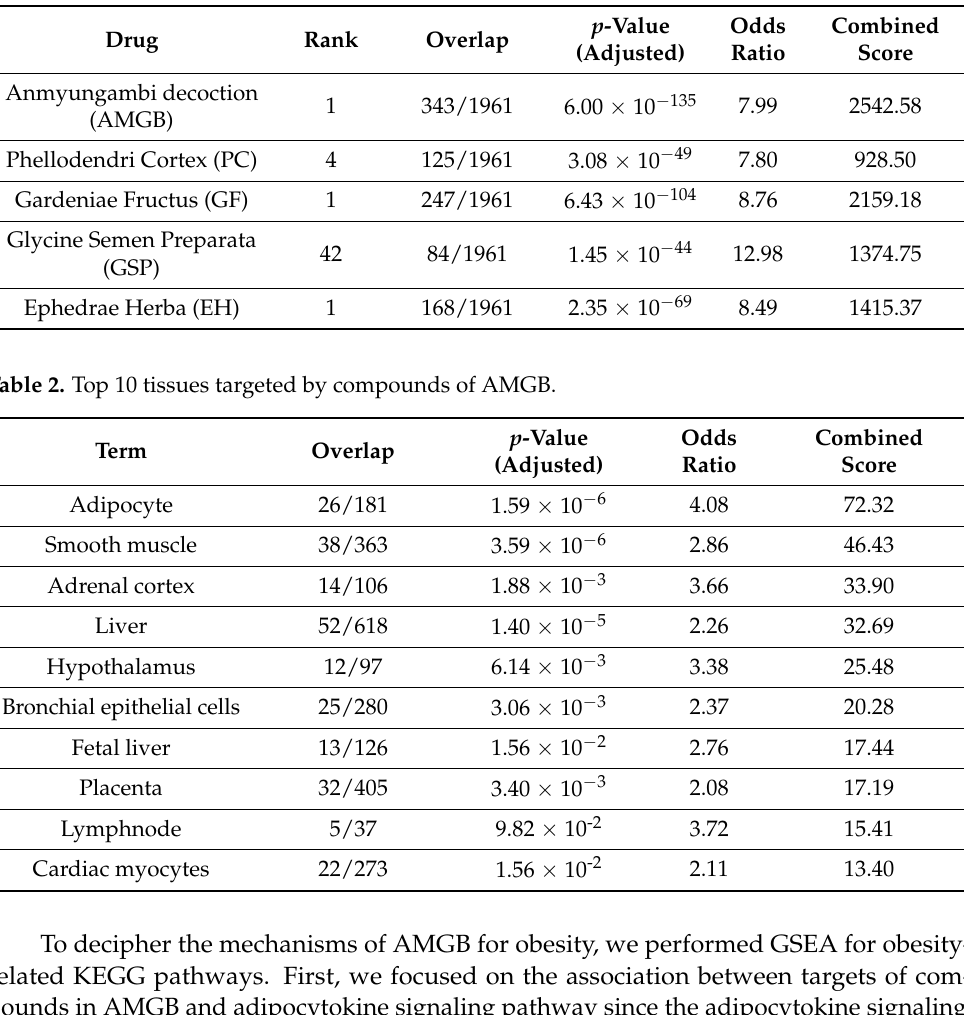
Table 1. GSEA of AMGB and individual herbs for obesity.